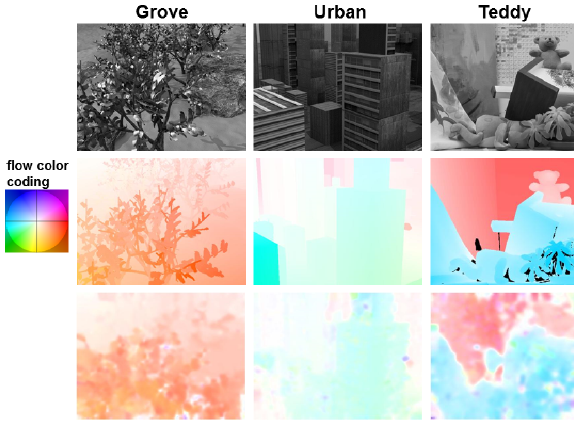
Figure 4: The top row shows the first frame of the input sequences used to our study. The middle row shows the color coded ground truth flow of each image. The bottom row shows the estimated optic flow of our algorithm. In the left-most column we visualize the color coded ground truth flow that indicate speed and direction.